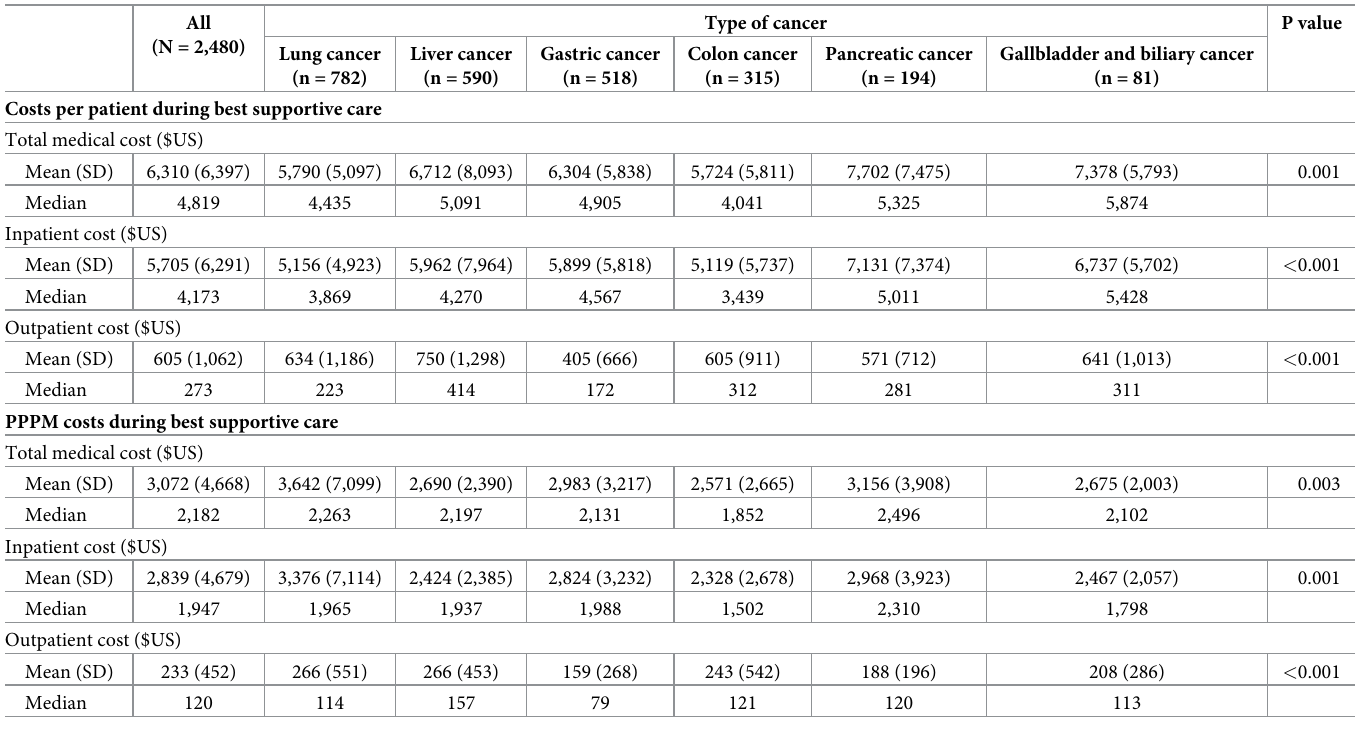
Table 3. Medical costs accrued by patients with cancer during best supportive care. All (N =